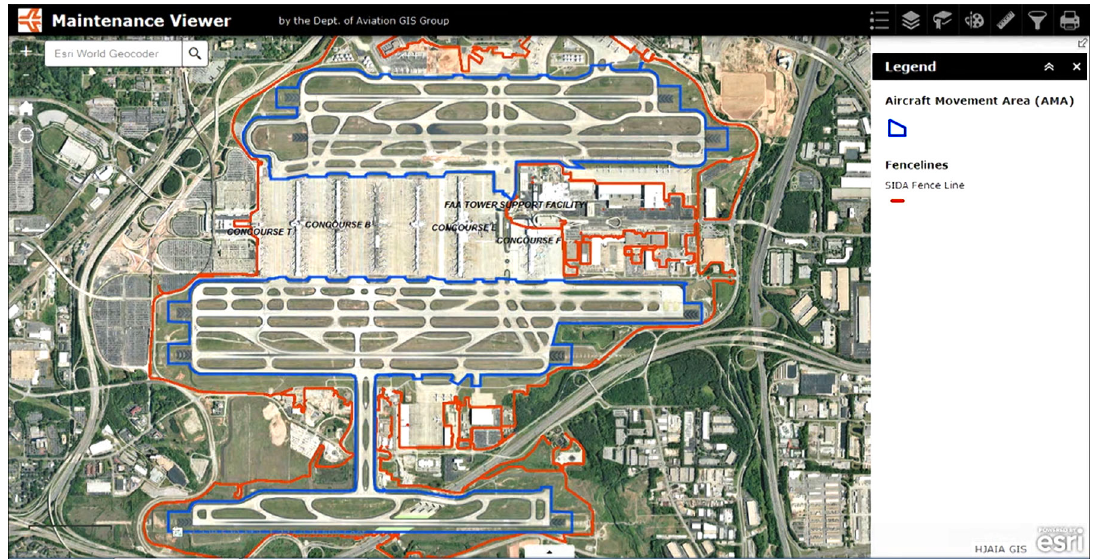
Figure 2. The viewer for a maintenance team that provides access to all the data necessary for its efficient operation (Hartsfield-Jackson Airport